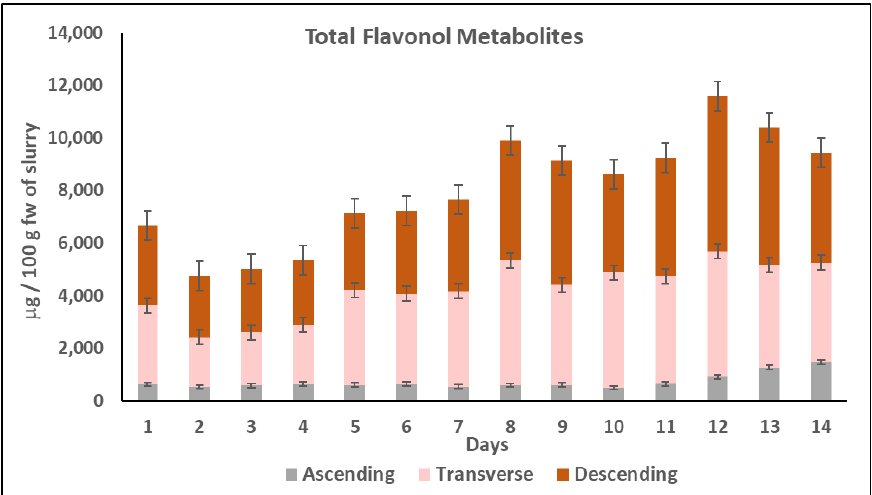
Figure 3. Total flavonols metabolites (µg/100 g fw of slurry) in the ascending colon (AC), transverse colon (TC), and descending colon (DC) during the colonic fermentation of HPP-treated onion. Data are the mean values ± standard deviation of three different determinations ( n = 3).